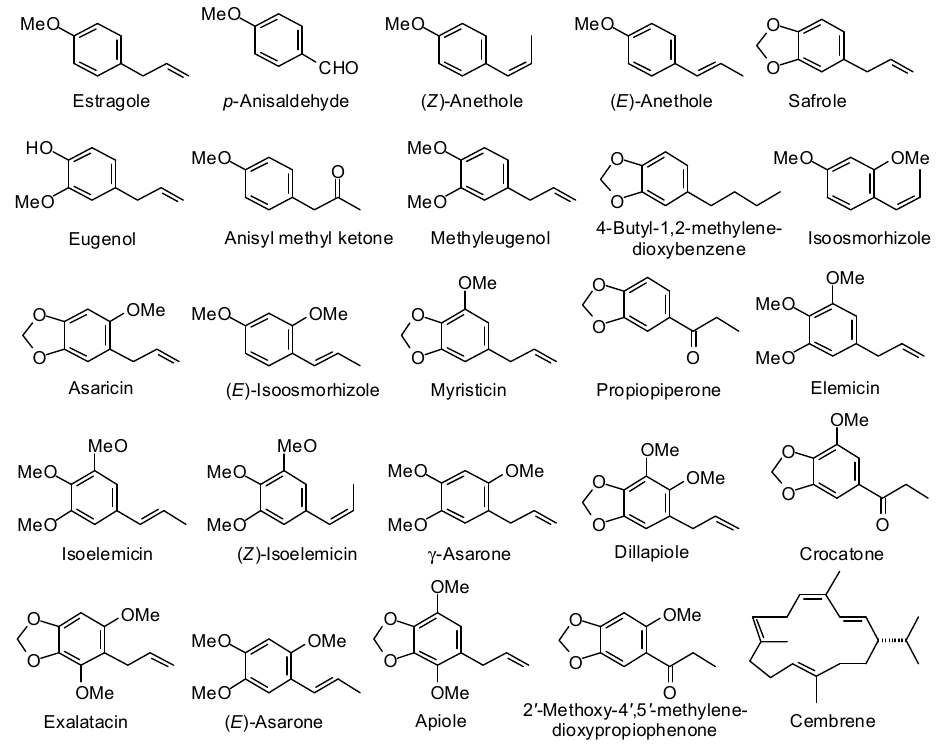
Figure A4. Major phenylpropanoids and miscellaneous compounds found in Neotropical Piper species.